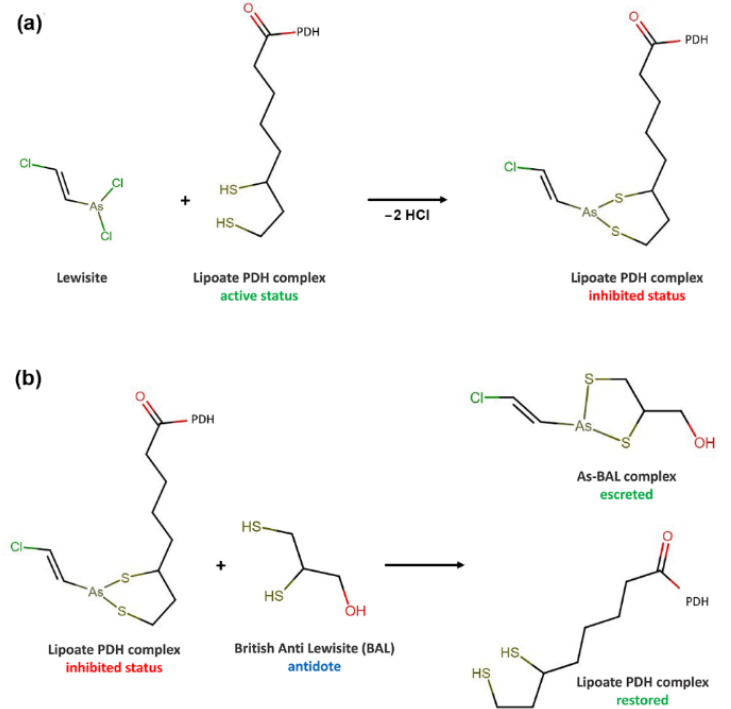
Figure 1. ( a ) Mechanism of Lewisite interaction (and similarly, monomethyl As(III) acid) with lipoic acid and the subsequent inhibition of PDH activity; ( b ) the antidote action of BAL and the restoring of PHD